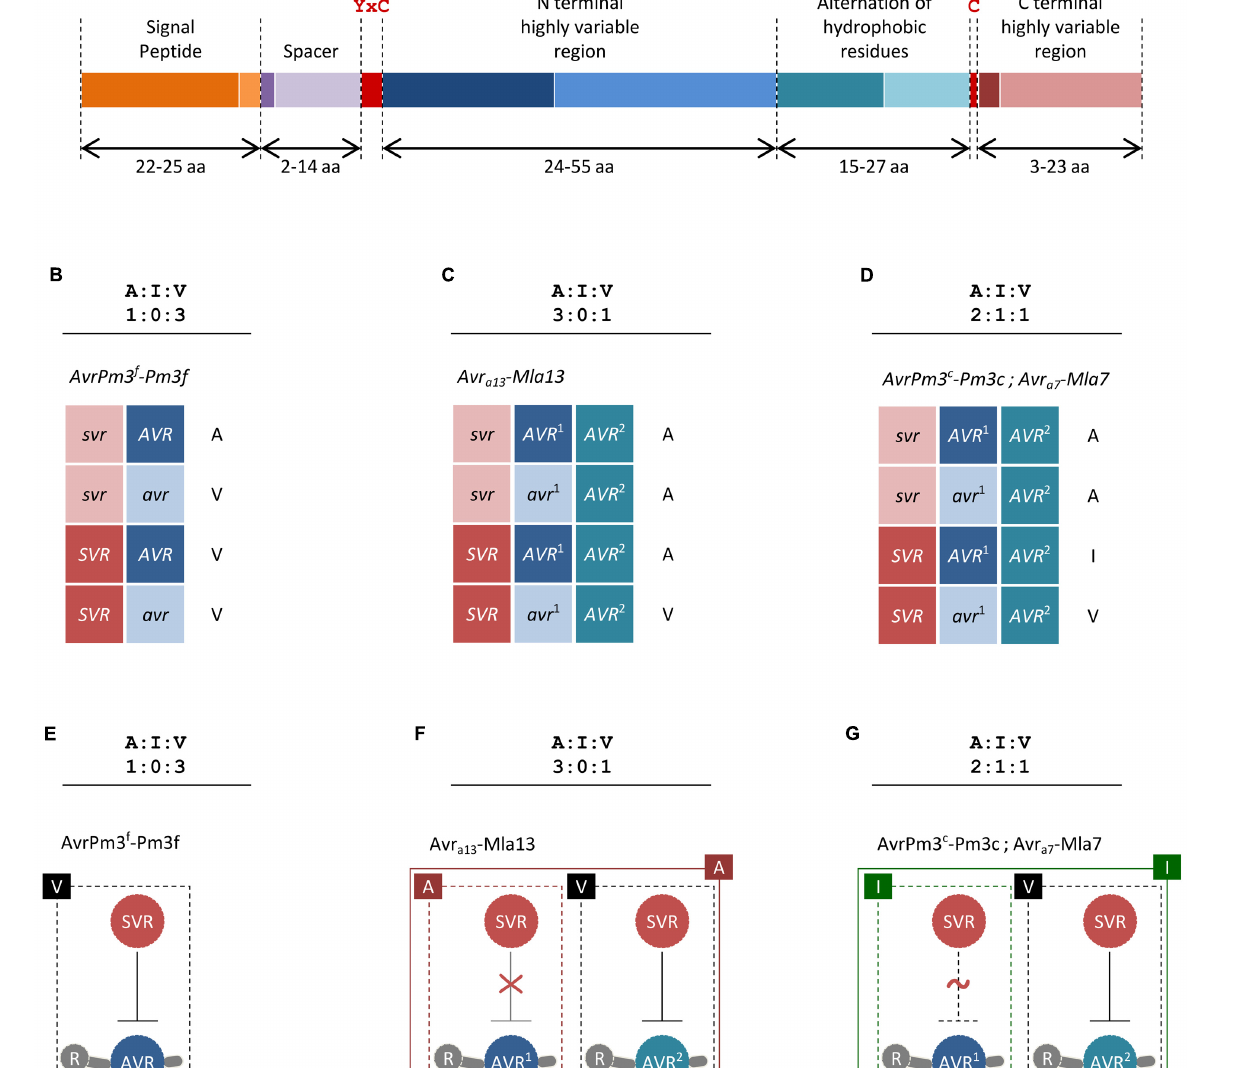
Frontiers in Plant Science |